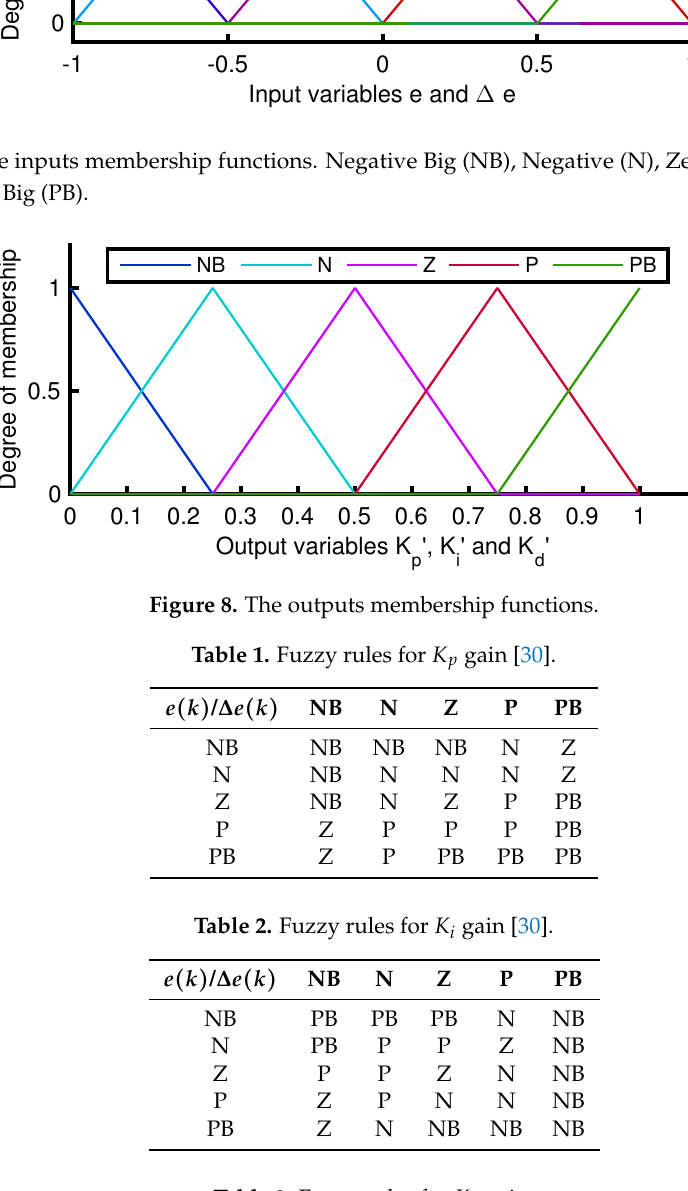
Table 3. Fuzzy rules for K d